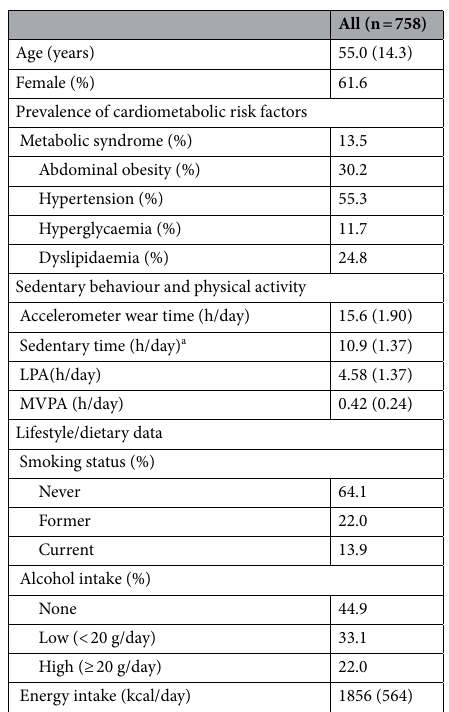
Table 1. Participant characteristics. Data shown are means (standard deviations) or percentages. LPA light physical activity, MVPA moderate-vigorous physical activity. Abdominal obesity, visceral fat area ≥ 100 cm 2 ; hypertension, systolic blood pressure ≥ 130 mmHg, and/or diastolic blood pressure ≥ 85 mmHg; hyperglycaemia, fasting brood glucose ≥ 110 mg/dL; and dyslipidaemia, triglyceride ≥ 150 mg/dL and/or high- density lipoprotein cholesterol < 40 mg/dL. a Sedentary time was expressed as the estimated hours of sedentary time per day given as standardised 16 h of accelerometer wear